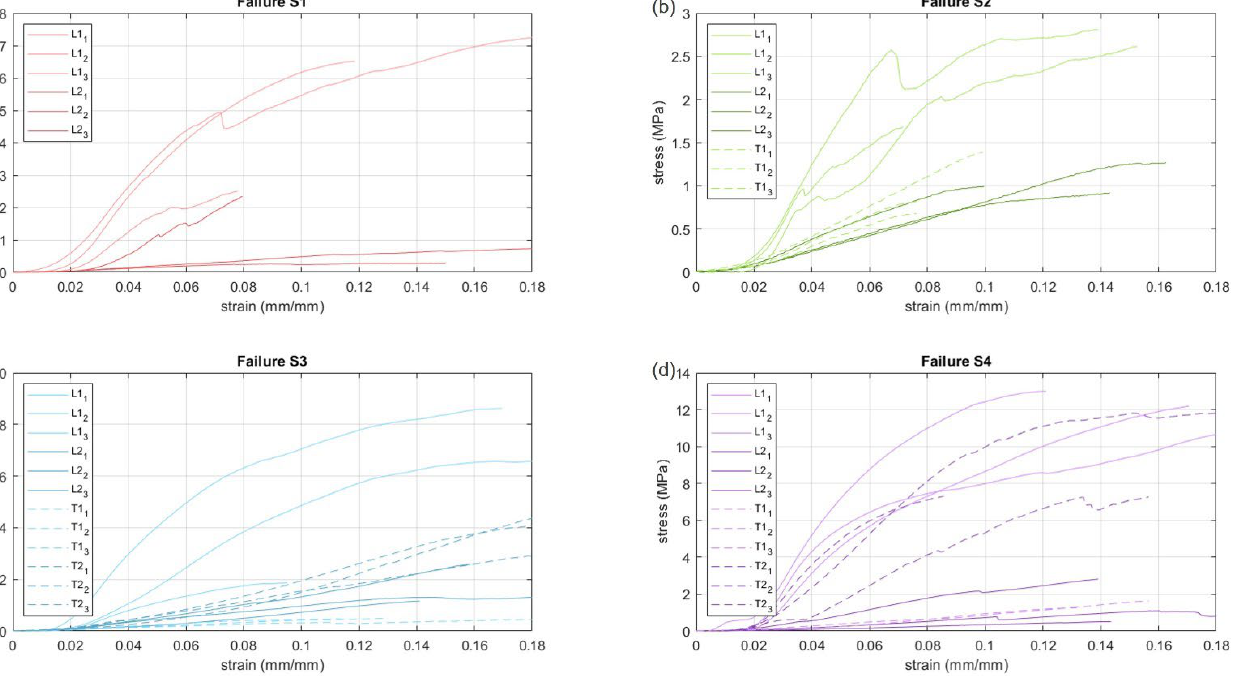
Figure 3. From ( a – d ) tensile tests up to failure for the fourth subjects along longitudinal (L) and transversal (T) directions of layer 1 or 2.